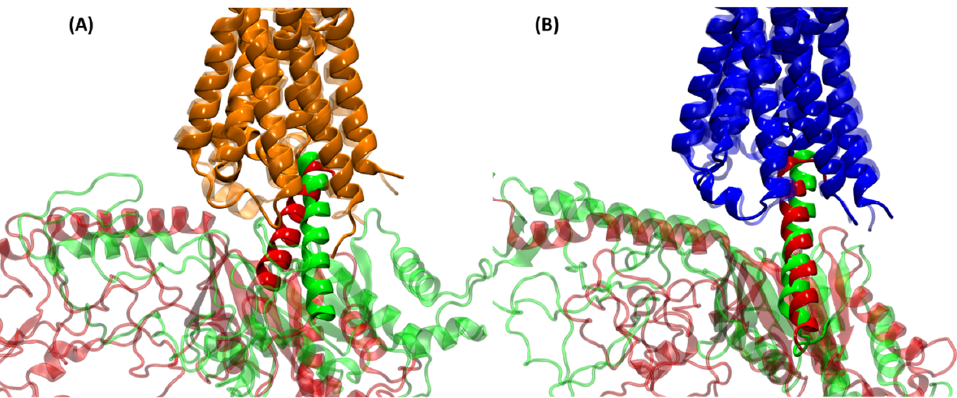
Figure 6. Comparison of the cognate complexes with the non-cognate complexes. (A) Overlay of M1:Gαq (orange/green) and M1:Gαi (light orange/red) complexes from the average MD structures; (B) Overlay of M2:Gαq (blue/green) and M2:Gαi (light blue/red) complexes from the average MD structures.